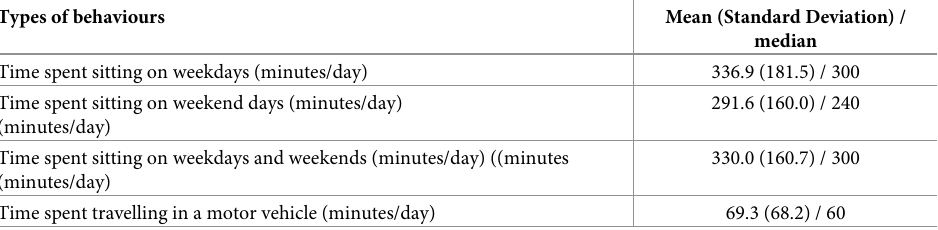
Table 2. Sedentary behaviours for participants of Alberta’s Tomorrow Project (n = 14,758).